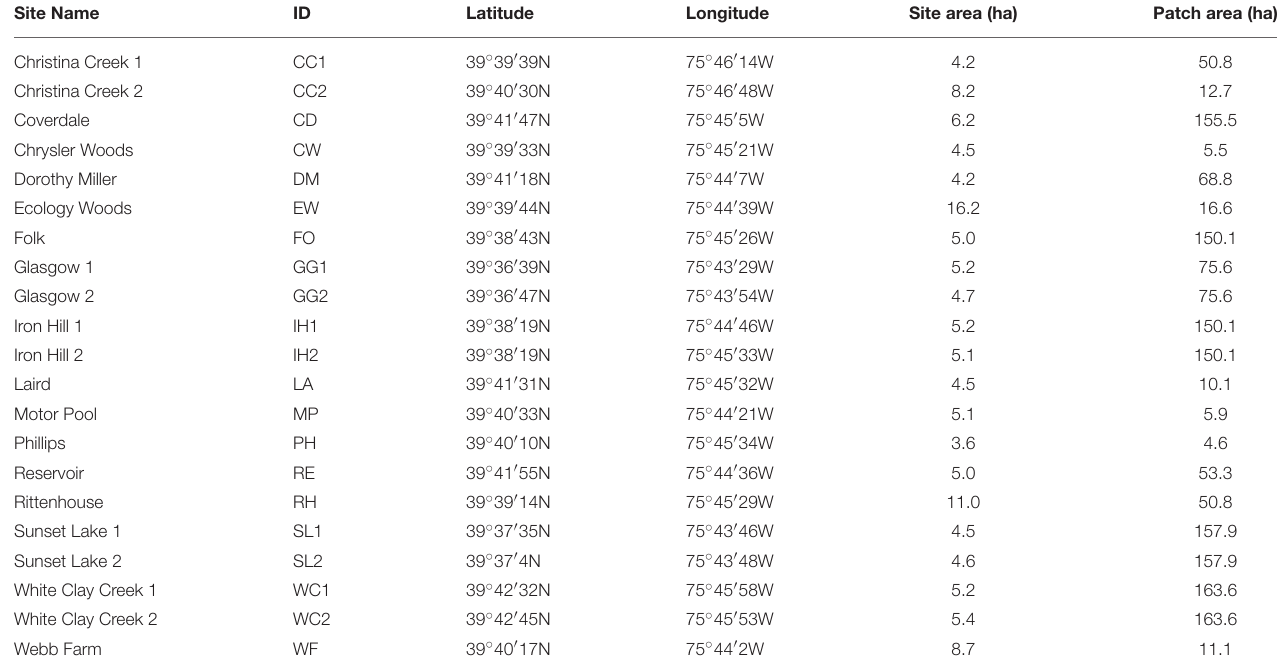
TABLE 1 | List of 21 study site names, IDs, locations, and site and patch areas (hectares) in and near Newark, Delaware,